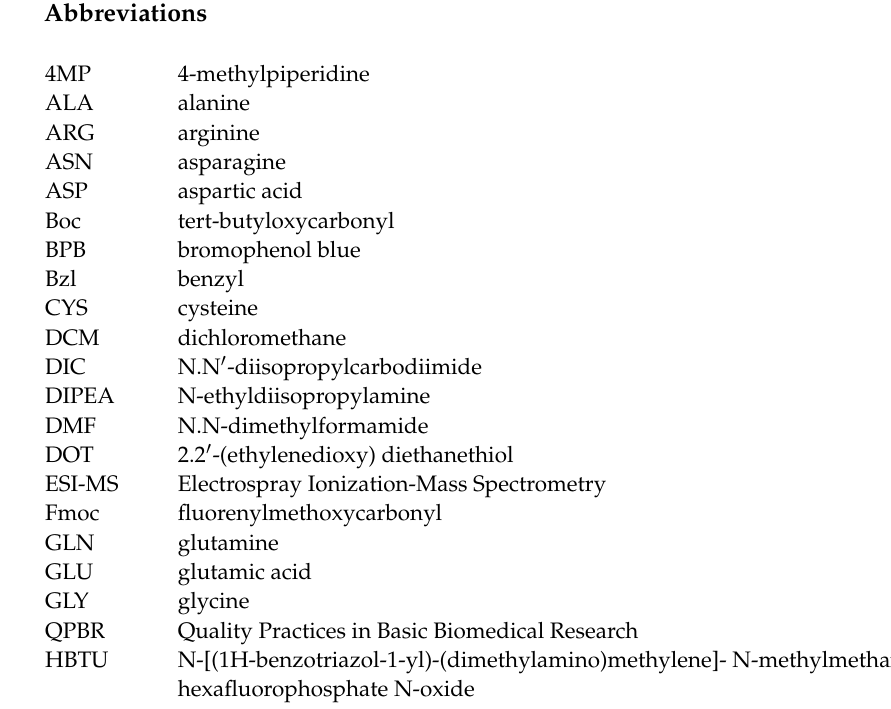
sequence, Table S3: Original variables calculated for each peptide sequence, Table S4: Importance of components, Table S5: Absolute values for the PCA factor loadings, Figure S1: Number of peptides grouped by frequency according to the obtained pure yield, and